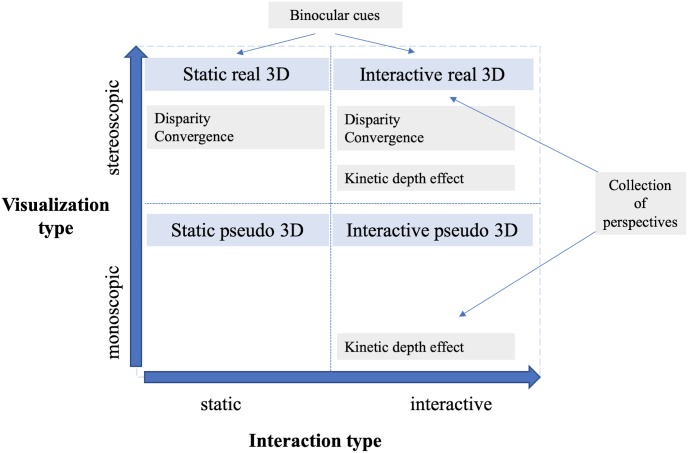
Scheme of the additional depth cues present in various settings.